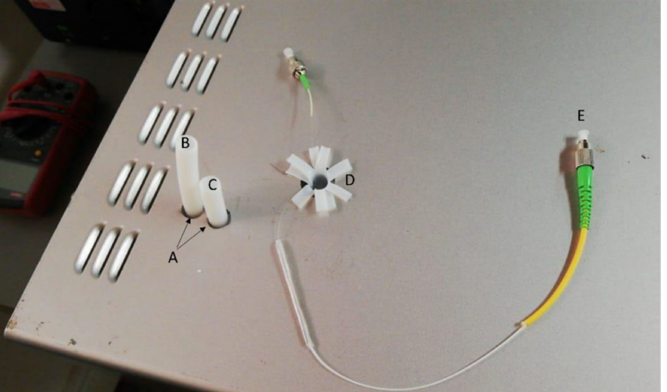
Figure 5. Microwave oven modified by means of holes. A : Holes on top of the microwave oven to enlarge the glass pipe using adaptation in Teflon. B and C : Output and Input of the liquid. D . Hole to allow the out of the optical fiber. E . Optical fiber